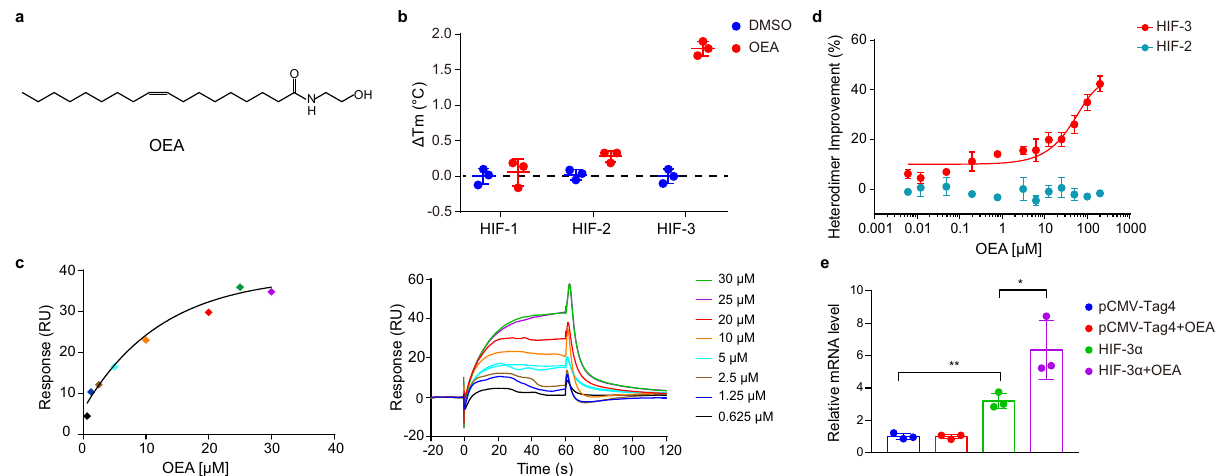
Fig. 2 Agonistic effects of OEA on the HIF-3 α -ARNT heterodimer. a Chemical structure of OEA. b Protein thermal shift assays measuring the change in melting temperatures ( Δ T m ) of HIF-1 α -ARNT, HIF-2 α -ARNT and HIF-3 α -ARNT (i.e., HIF-1, HIF-2 and HIF-3) complex proteins in the presence of 20 μ M OEA. c Binding of OEA to the HIF-3 α PAS-B domain (K D about 14.0 μ M) as measured by SPR. d Effects of OEA on the heterodimerization of HIF-3 α -ARNT and HIF-2 α -ARNT, detected by TR-FRET. e The effects of HIF-3 α overexpression and 25 μ M OEA treatment on the expression of HSPA6 in HEK293 cells. ** p = 0.0019 for pCMV-Tag4 vs. HIF-3 α , * p = 0.0437 for HIF-3 α vs. HIF-3 α + OEA. Error bars, mean ± SD.; n = 3 (biological replicates) for ( d , e ). Statistical signi fi cance: * p < 0.05, ** p < 0.01 (Unpaired two-tailed t